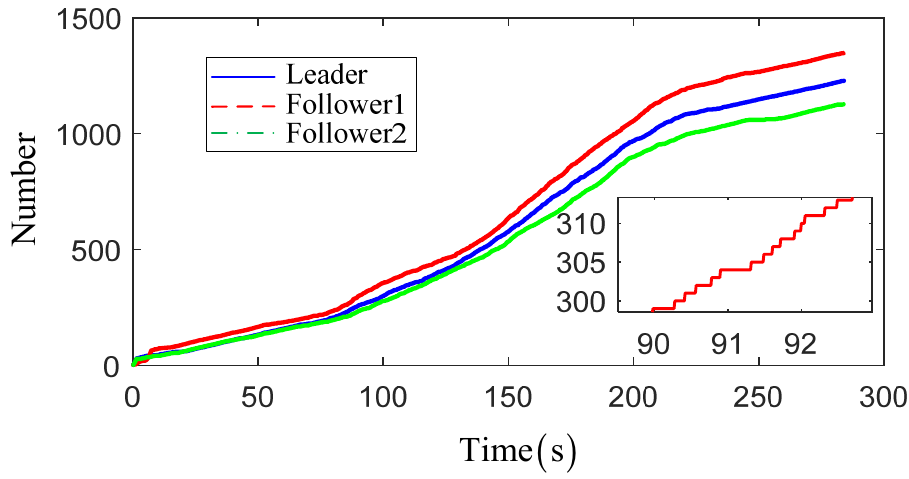
Figure 8. The event-triggered cumulative number for USVs.